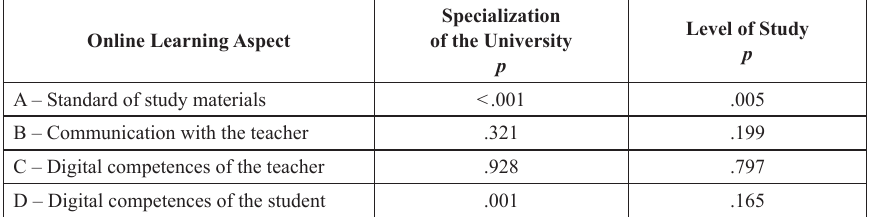
Table 10. Significance of differences between attitudes towards online learning aspects